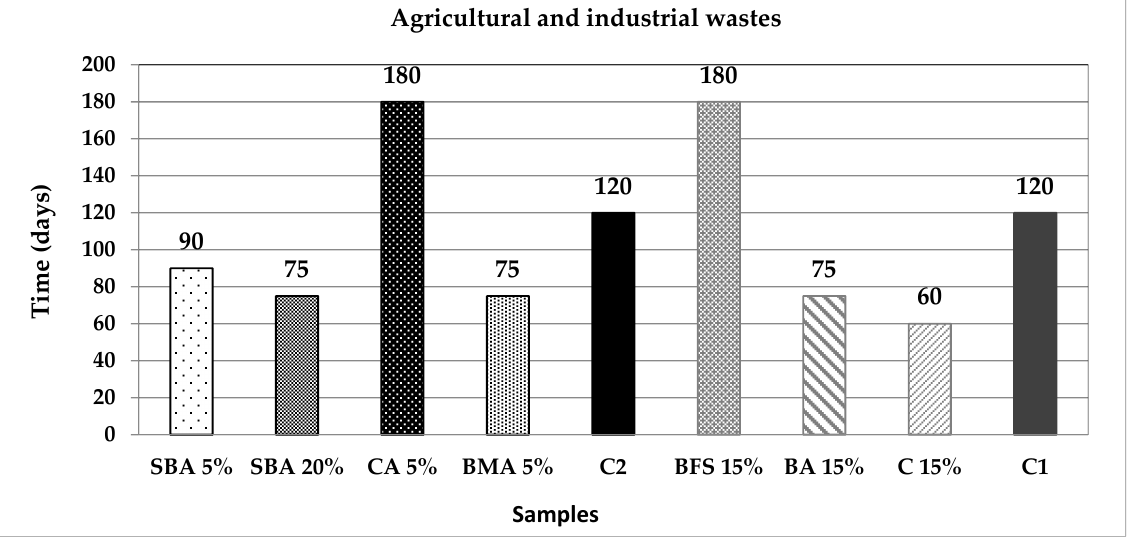
Figure 11. Critical time to reach out 25 mm of carbonation front, for the agricultural and industrial wastes group of addi- tions.